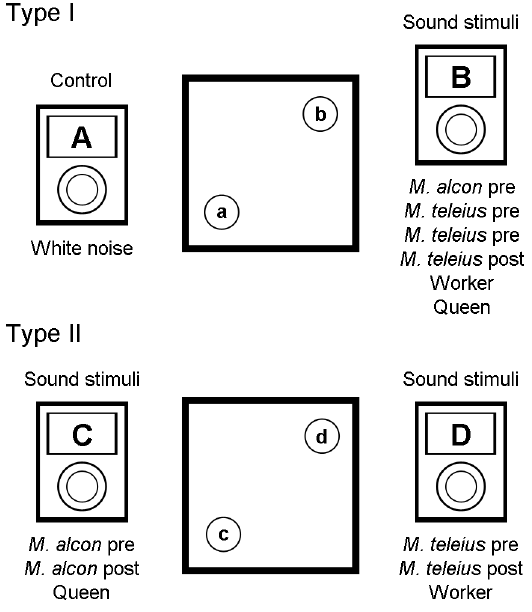
Figure 1. The two playback experimental setups. In the first set of playback bioassays (Type 1) the sounds emitted by Myrmica scabrinodis queens and workers and pre- and post-adoption Maculinea alcon and M. teleius larvae (stimuli) were tested against a white noise (control). In the second experimental setup (Type 2) we tested simultaneously two acoustic stimuli: the sounds of pre-adoption larvae of the two parasite species ( M. alcon pre vs . M. teleius pre), the acoustic emissions produced by integrated parasite larvae ( M. alcon post- vs . M. teleius post-adoption) and the sound of M. scabrinodis castes (Queen vs .